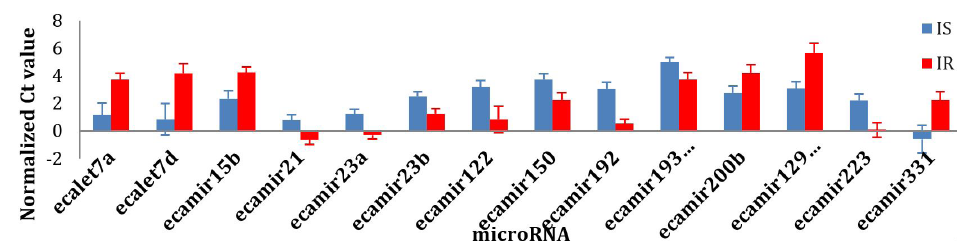
Figure 6. Delta Ct values of significantly different miRNAs between groups: combined insulin resistant animals (IR, n = 10) versus combined insulin sensitive animals (IS, n